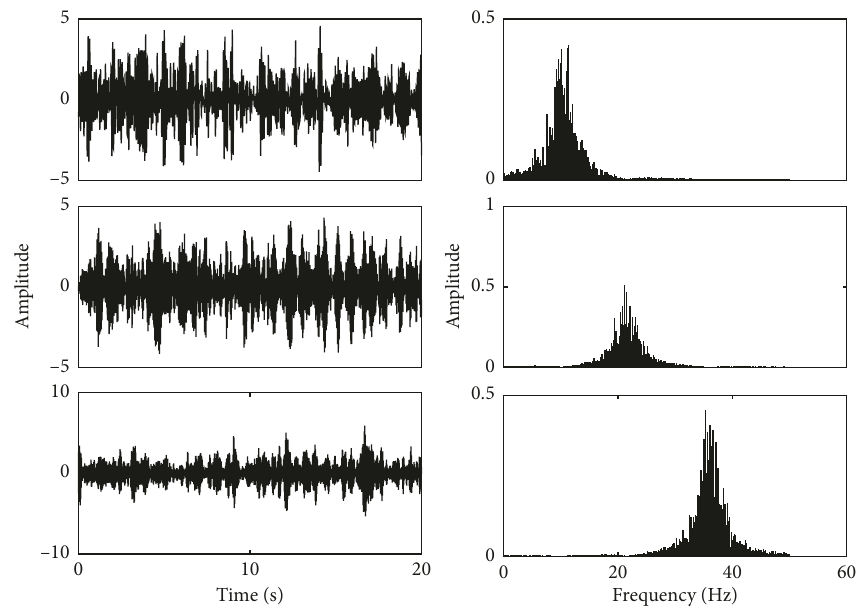
Figure 4: Waveform and spectrum of IMFs by VMD for LFM signal. Table 1: The kurtosis values and mutual information (MI) of IMFs for LFM signal.